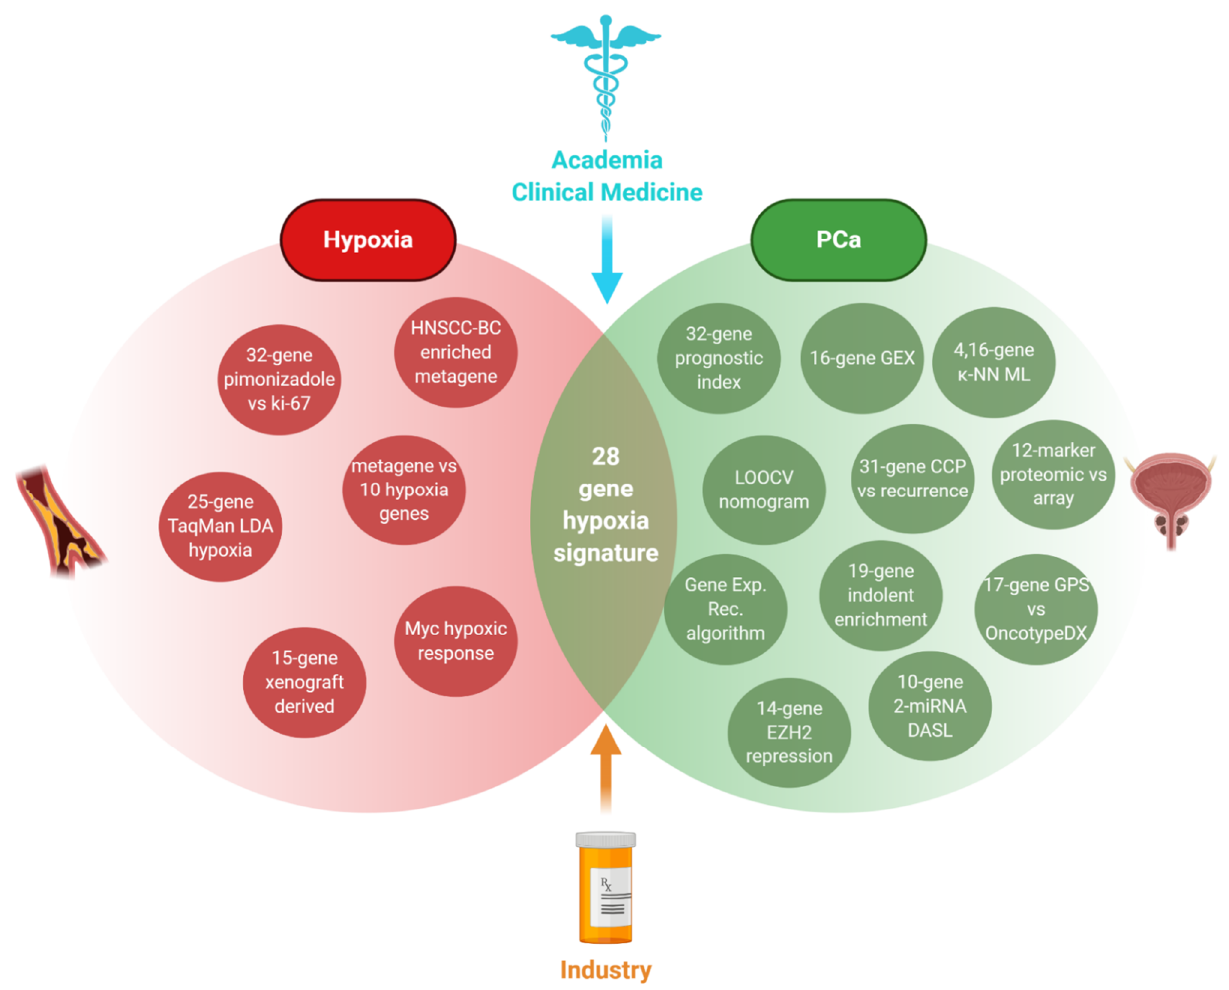
Figure 3. Composition of the 28 hypoxia gene signatures to prognosticate localized PCa and exemplify derivation of prognostic signatures by combining multiple sub-signatures [40]. The hypoxic component was comprised by (1) a 25-gene signature identified through TaqMan Low Density Array-Hypoxia Scores on tumor samples from 80 head and neck squamous cell carcinoma (HNSCC) patients [92], (2) a metagene enriched in hypoxia-regulated pathways through in vivo co-expression pattern data from head, neck, and breast cancer studies [93], (3) studies linking Myc to the modulation of the hypoxic response [94], (4) a 32-gene signature positively correlating to Ki-67 staining that was shown to link the hypoxia marker pimonidazole and aggressive PCa [95], (5) a 15 gene hypoxia-related expression classifier from in vivo xenograft tumors validated in 323 HNSCC patients [96], and (6) a metagene obtained by analysis of genes whose in vivo expression clustered with the expression of 10 well-known hypoxia-regulated genes [97]. Created with BioRender.com.